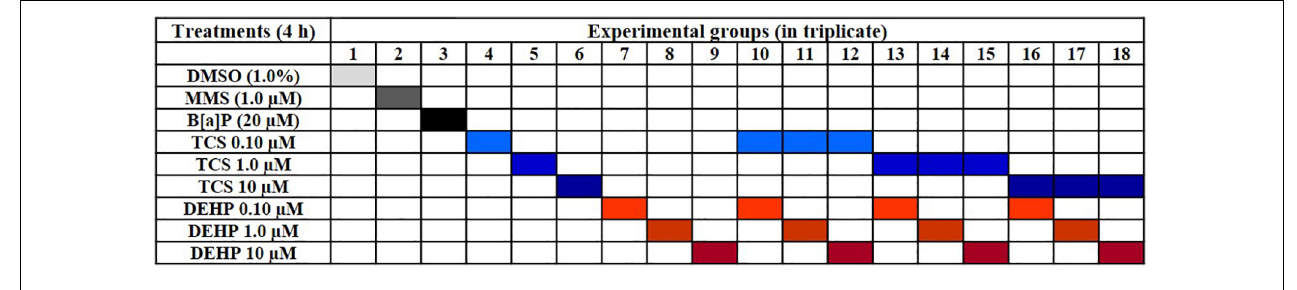
FIGURE 1 | Schematic overview of treatments carried out in the study. TABLE 1 | Impact of exposure to triclosan (TCS), to phtalate DEHP, as well as their combinations on biomarkers of cell death (apoptosis and necrosis), cell viability (nuclear division index, (NDI); and nuclear division citotoxicity index (NDCI) and DNA instability (micronuclei (MN), nuclear buds (NBUDs) and nucleoplasmatic bridges (NPBs), in HepG2